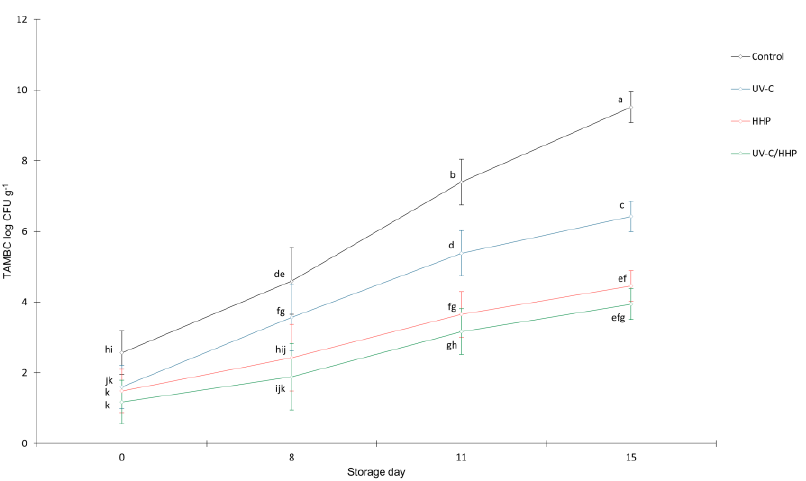
Figure 1. Total aerobic mesophilic bacteria count (TAMBC) of untreated (control) and treated (UV-C, HHP, and UV-C/HHP) raw, fresh-cut potatoes during storage. Error bars represent standard errors; lowercase letters represent a significant difference within means ( p < 0.05).